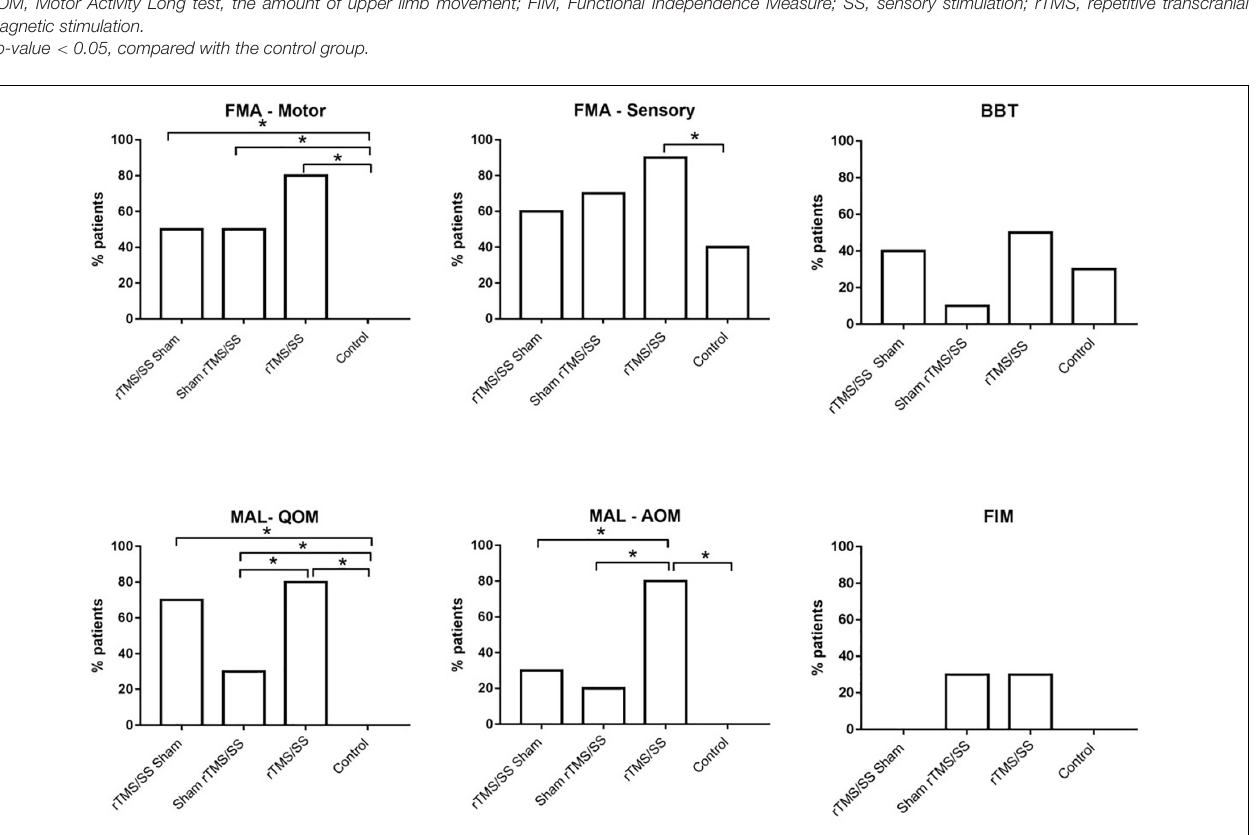
patterned rTMS, over the contralesional S1 paired with motor training, resulted in substantial UL motor improvements. To date, no clinical trial has combined rTMS over S1 with